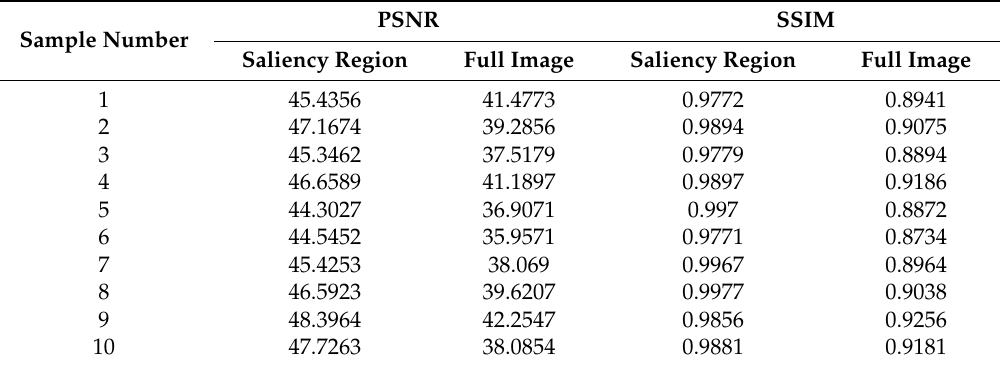
Table 2. The comparison effect of saliency region and full image reconstructed.